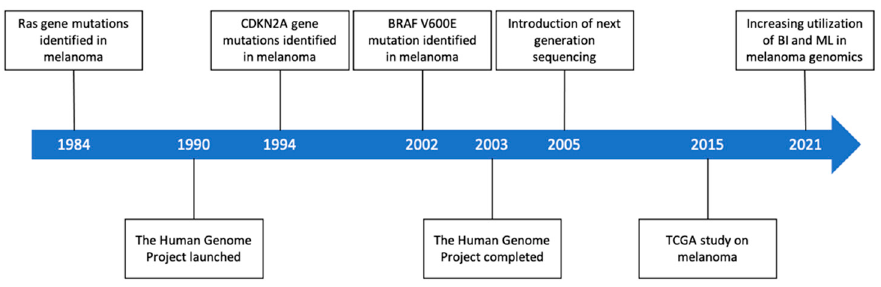
Figure 1. Key advances in melanoma genomic research. BI: bioinformatics, ML: machine learning.